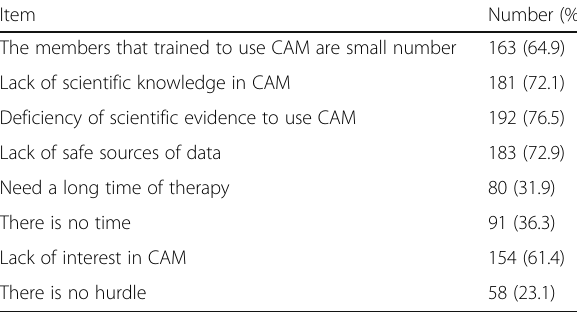
Table 10 The barriers that limit the appropriate use of complementary and alternative medicine as reported by the